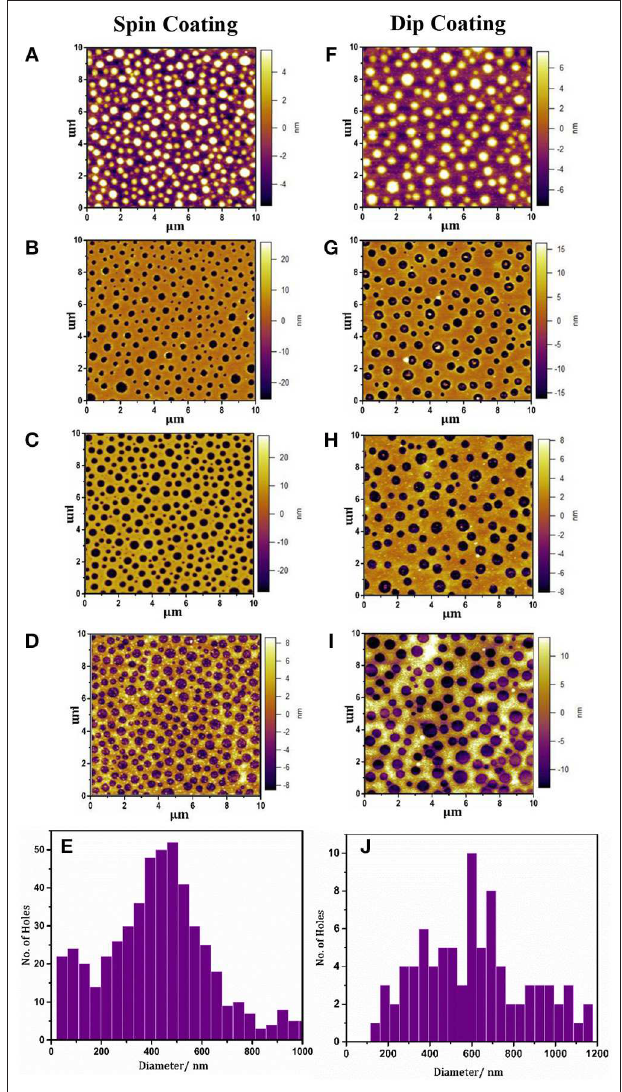
FIGURE 2 | AFM images showing the morphology of: (A) the PS:PMMA polymer-blend (15mg ml − 1 ) spin cast onto an 11nm Cu film on PET substrates, showing spherical PS islands dispersed in a PMMA matrix; (B) following the selective removal of PS using cyclohexane the peaks are transformed into holes; (C) the resulting PMMA film is UV/O 3 treated to remove residual polymers within the holes and to ensure the holes extend right through the PMMA to the underlying metal; (D) ammonium persulfate etched Cu film showing circular apertures. (F–I) are representative AFM images showing the morphology of the film when the same steps are repeated following the deposition of the polymer-blend by dip coating; Histograms showing the size distribution of apertures computed for 10 × 10 µ m 2 AFM images of the etched Cu electrode where the PMMA mask was fabricated by spin coating (E) and dip coating (J) the PS/PMMA